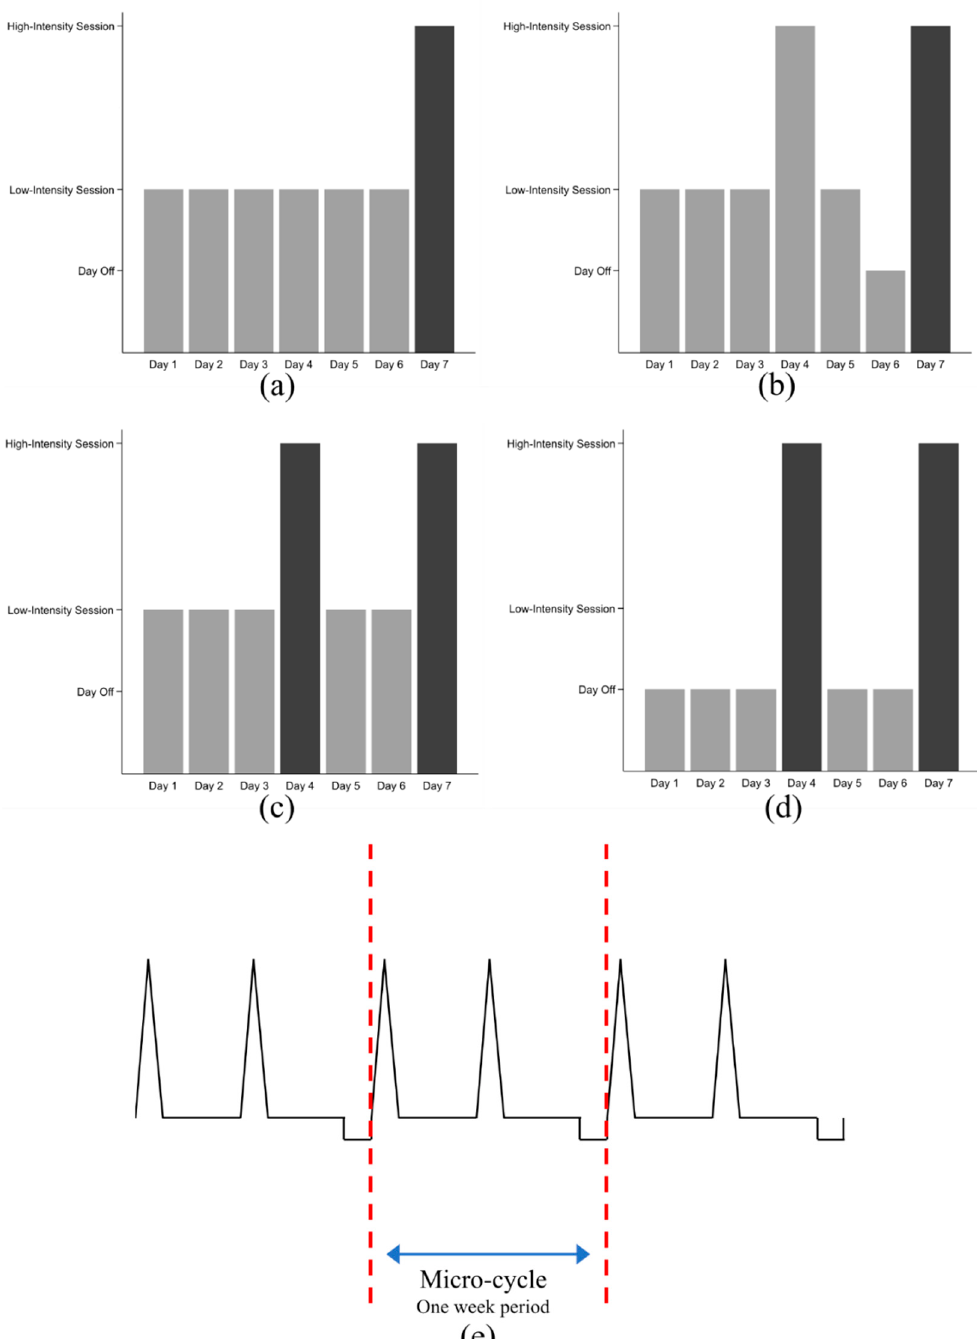
Figure 2. The four primary models of the training micro-cycle as described by 48 greyhound trainers across New Zealand. Racing days are highlighted by the dark grey bars and training days are shaded light grey; ( a ) low-intensity based training programme with 1 race (day 7) per week; ( b ) trainers give greyhounds 1 mid-week high-intensity training session; ( c ) low-intensity based training system with 2 race days per week; ( d ) training system where greyhounds race twice each week and do not participate in any workouts between race-days; ( e ) represents a typical training micro-cycle. The high-intensity training or racing load is indicated by the peaks, which are followed by a plateau of low-intensity work, which allows a period for rehabilitation and recovery before the next training load. Two of these cycles are typically followed by a rest period before the next load cycle. The racing schedule dictates the micro-cycle where greyhounds have 2 rest or low-intensity days to 1 high-intensity day.